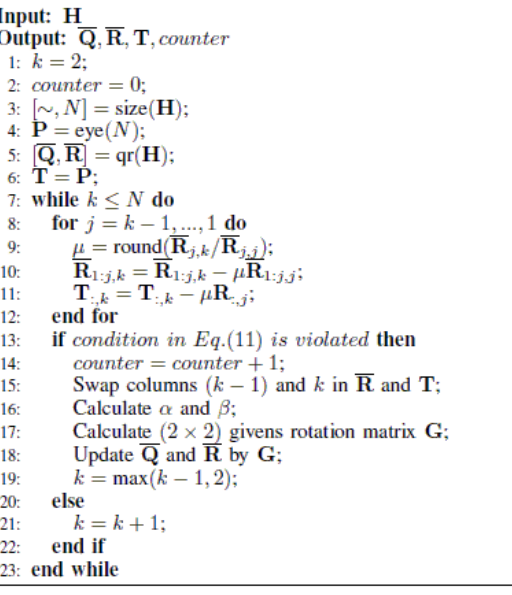
Fig. 2. LLL algorithm.